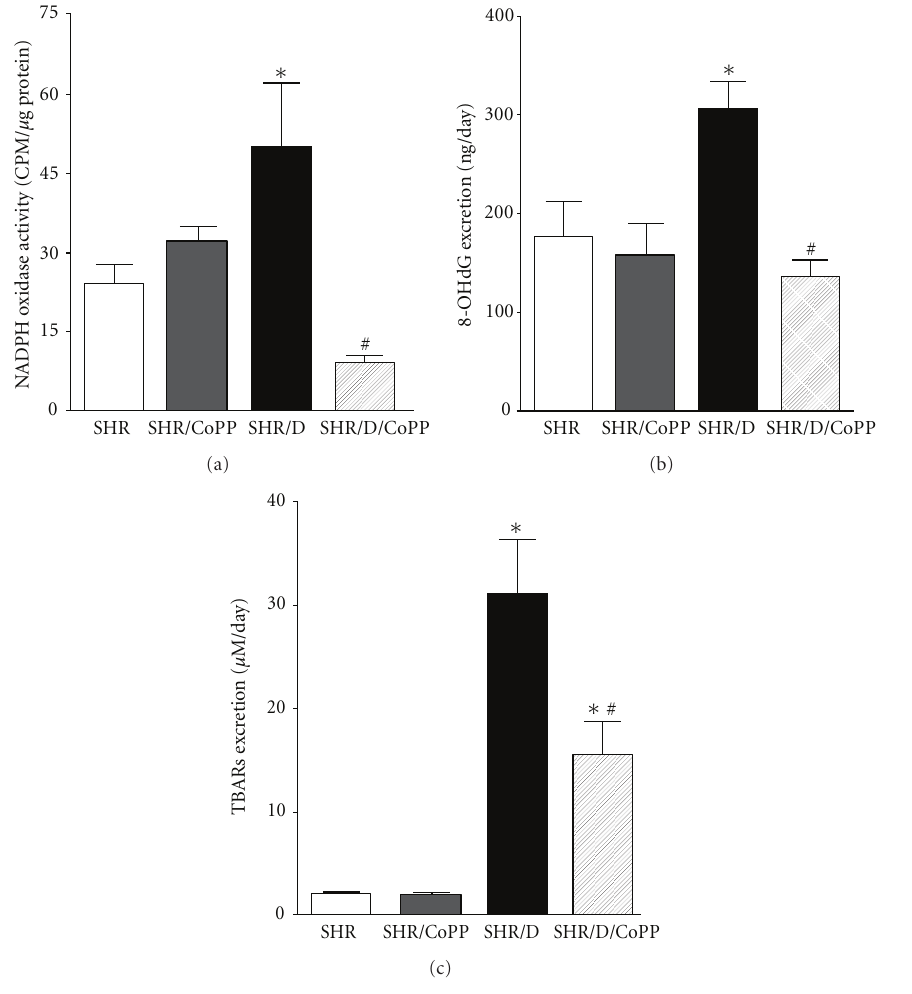
Figure 4: Cortical NADPH oxidase activity (a), urinary thiobarbituric acid reactive substances (TBARs) and urinary 8-hydroxy deoxyguanosine (8-OHdG) excretion levels (b) and (c), respectively, in control and diabetic SHR with or without CoPP treatment ( n = 8, ∗ indicates significant di ff erence from control SHR, # indicates significant di ff erence from diabetic